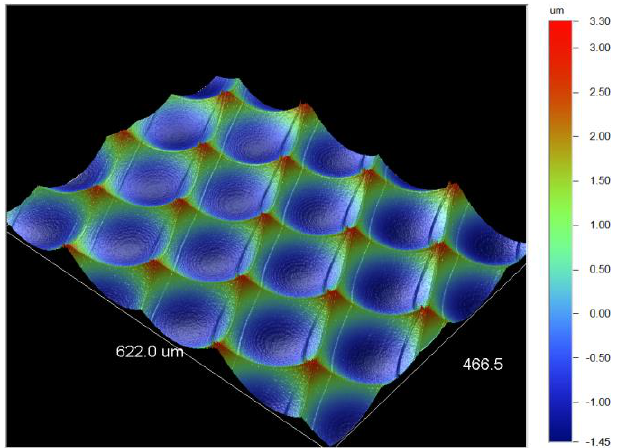
Figure 12. MLA on a test substrate with resulting microlenses after significant tool wear of the cutting diamond measured by WLI. diamond measured by